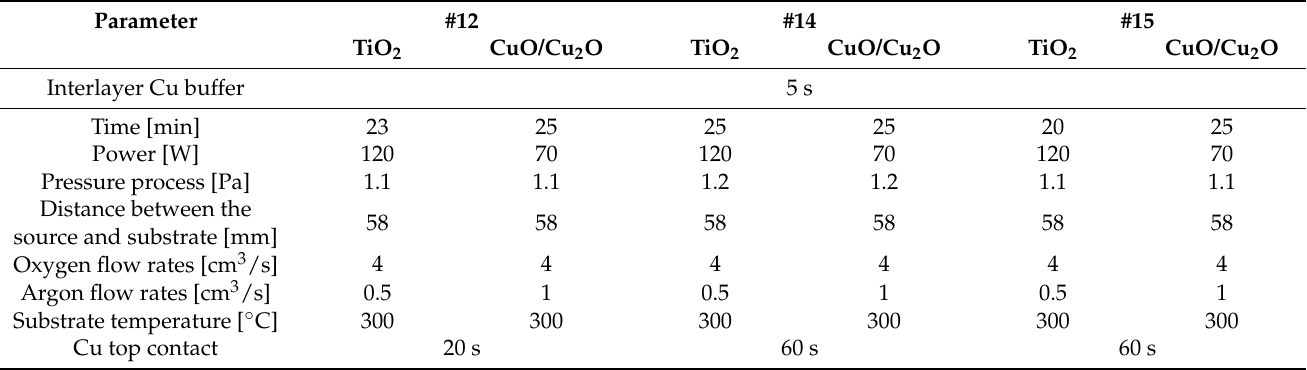
Table 1. Deposition conditions for #12, #14, and